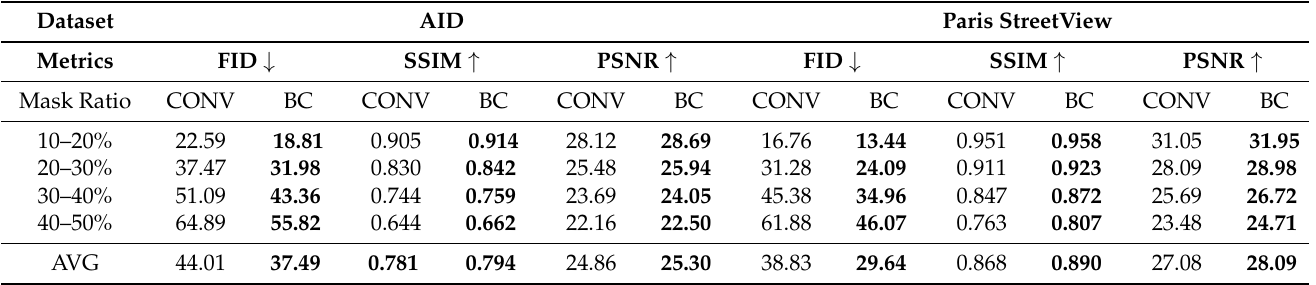
Table 5. Analysis of the BC block network on the AID and Paris StreetView datasets.